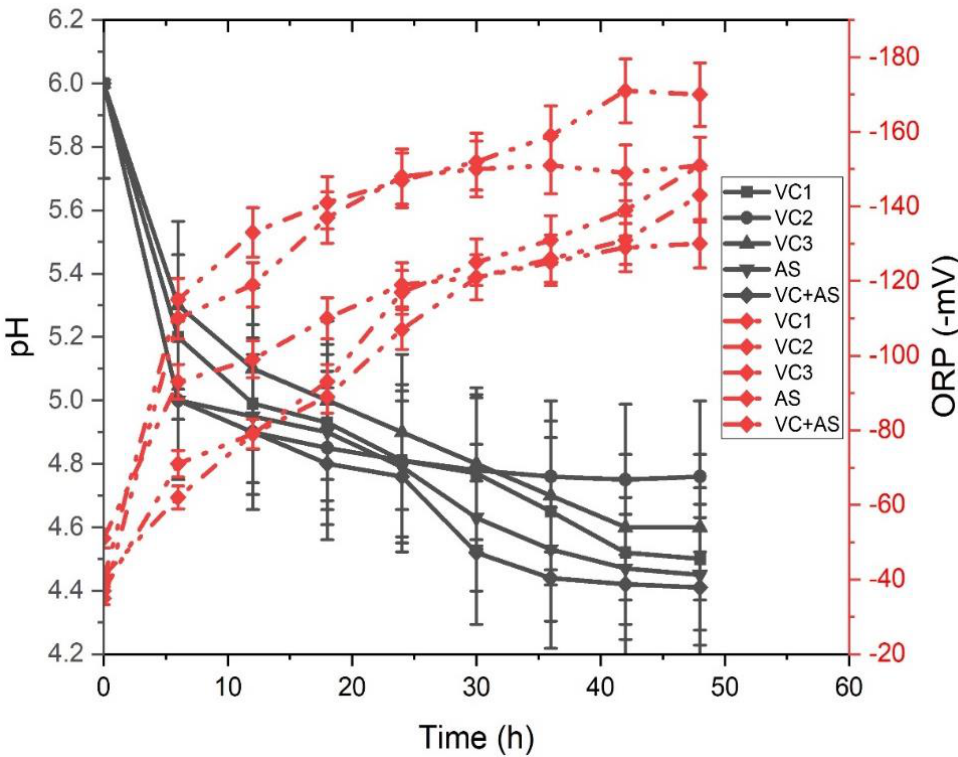
Figure 5. pH and ORP changes concerning different experimental conditions.